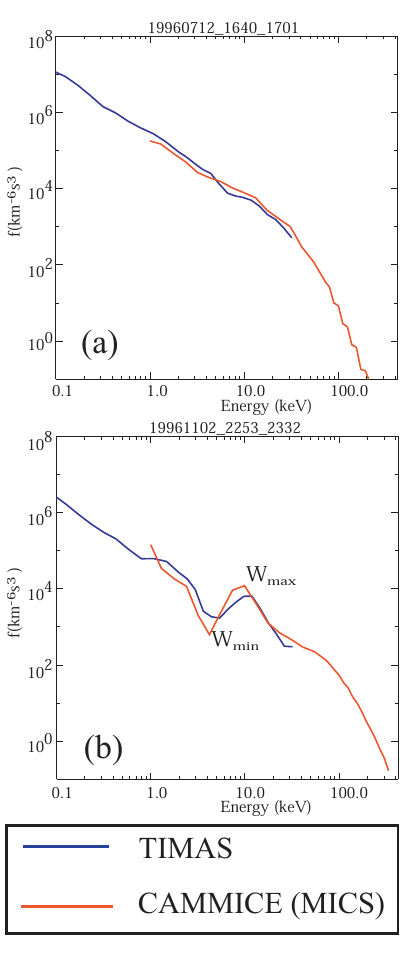
Fig. 4. Example IDFs from the statistical database. TIMAS data is shown in blue and CAMMICE (MICS) data is shown in red. Fig- ure ( a ) illustrates an IDF without a positive gradient region and thus would not be considered as a candidate for a wave energy source. Figure ( b ) indicates an IDF that would be a suitable wave energy source and thus would be included in the study. Two further param- eters are indicated in Fig. (b) which are later used to indicate over what particle energy range the positive gradient region and thus free energy is located; W min and W max . W min indicates the lower en- ergy location of the positive gradient region, while W max indicates its upper energy limit. For a further explanation of the use of W min and W max in calculations, refer to the main